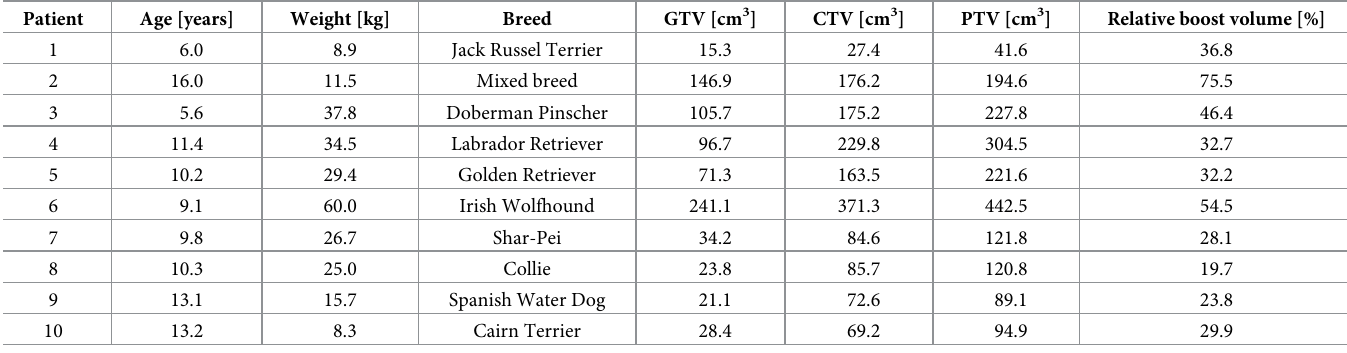
Table 1. Patient characteristics and target volumes.